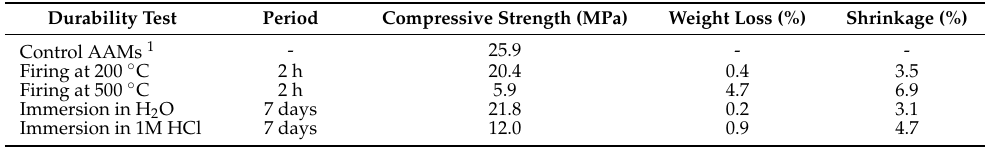
Table 7. Selected properties of PLR50MK50 AAMs obtained from durability